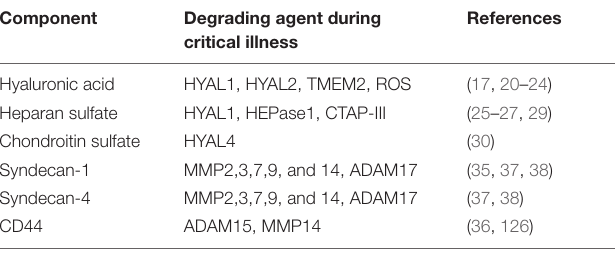
TABLE 1 | Glycocalyx-degrading agents in critical illness.